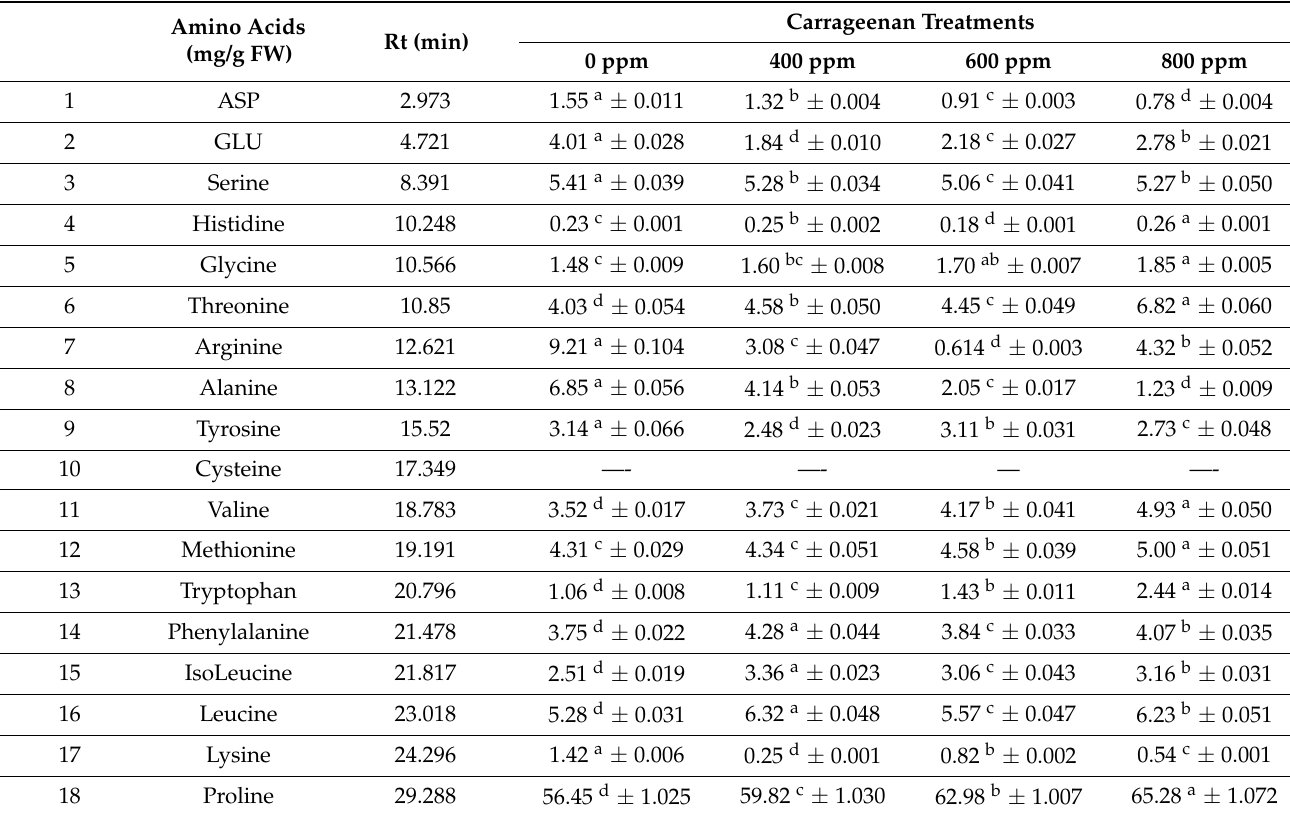
Table 3. HPLC analysis of free amino acids in Catharanthus roseus leaves treated with κ